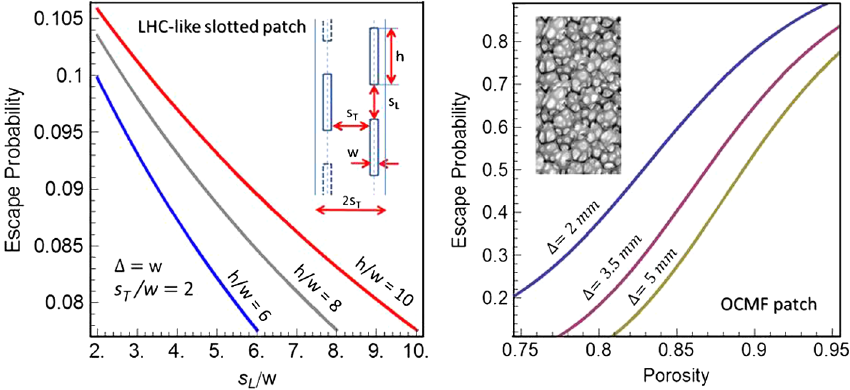
FIG. 5. Left: escape probabilities for LHC-like slotted patches. Right: escape probability for OCMF